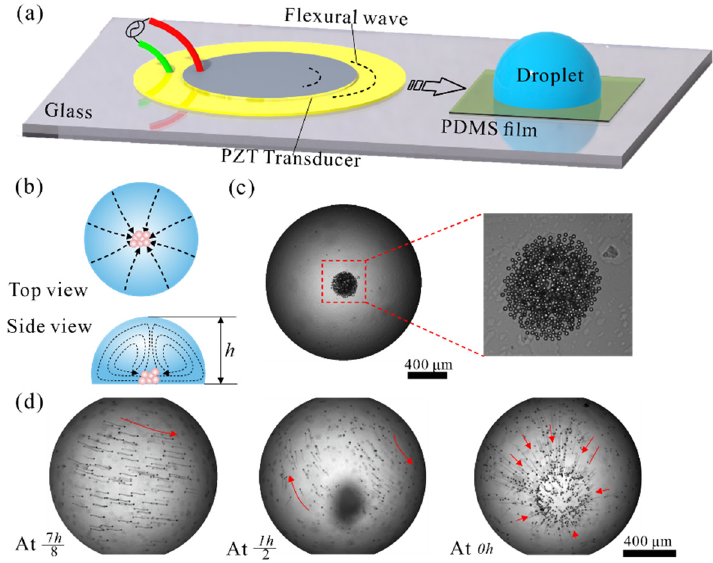
Figure 1. ( a ) Schematic presentation of the acoustofluidic concentration device. ( b ) Principle of the concentration process. ( c ) Experimentally observed 10 µ m particle concentration at 48 kHz, 40 Vpp. ( d ) The trajectory of particles in cross-sections at different heights.